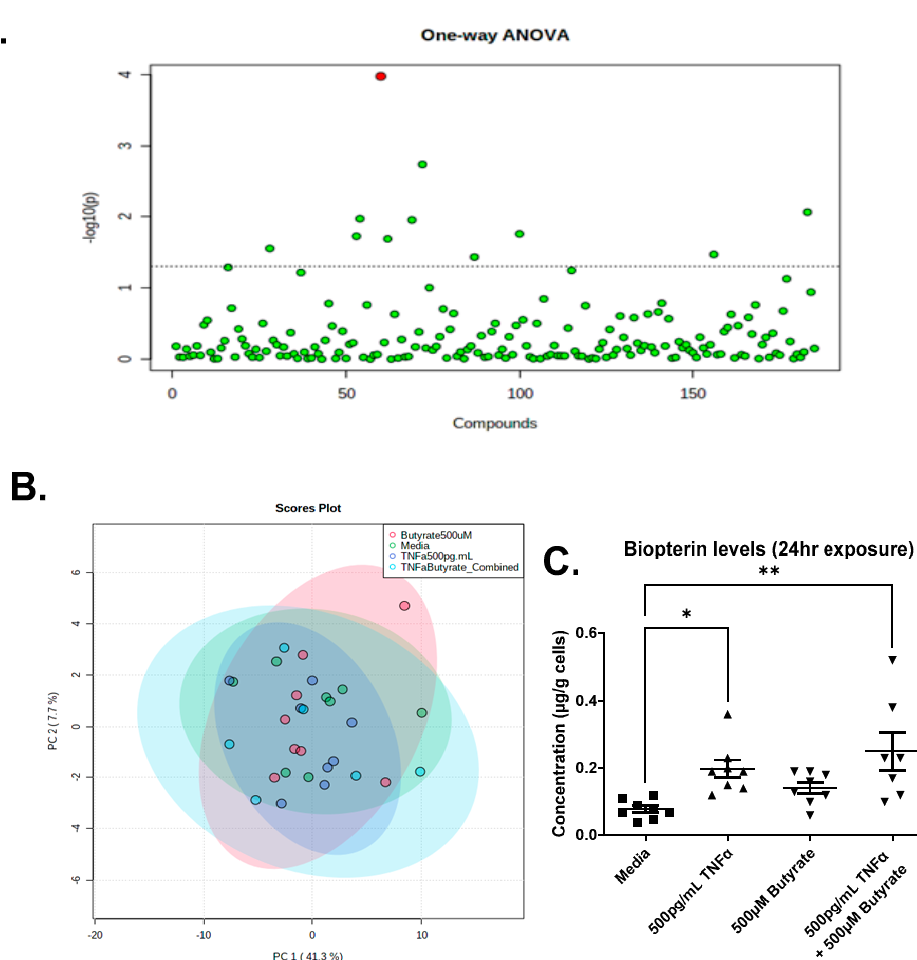
Figure 11. Metabolomics analyses reveal elevated biopterin in rodent CECs following with TNF α . ( A ) One-Way ANOVA showing Biopterin as the only differentially abundant metabolite treatment with TNF α . ( A ) One-Way ANOVA showing Biopterin as the only differen- following FDR correction; ( B ) PCA Scores plot for all treatments; and ( C ) Semi-quantitative levels of tially abundant metabolite following FDR correction; ( B ) PCA Scores plot for all treat- biopterin in primary rat colon epithelial cells after 24 h exposure to butyrate and TNF α . Data are ments; and ( C ) Semi-quantitative levels of biopterin in primary rat colon epithelial cells presented as mean ± standard deviation. Asterisks indicate degree of significance from medium after 24 h exposure to butyrate and TNF α . Data are presented as mean ± standard devia- control (One-way ANOVA followed by a Dunnett’s multiple comparison test, n = 7–8; significance tion. Asterisks indicate degree of significance from medium control (One-way ANOVA determined at * = p < 0.05, ** = p < followed by a Dunnett’s multiple comparison test, n = 7–8; significance determined at *= p < 0.05, ** = p < 0.01).